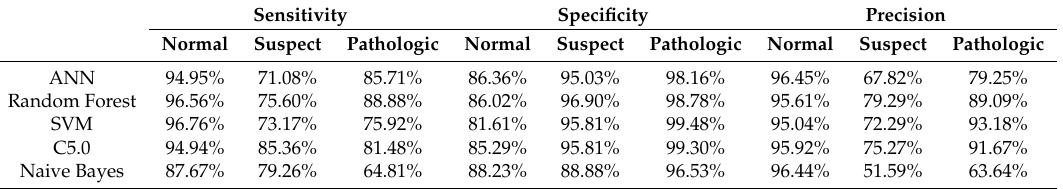
Table 5. Evaluation Criteria for CTG data for prediction before genetic algorithm.